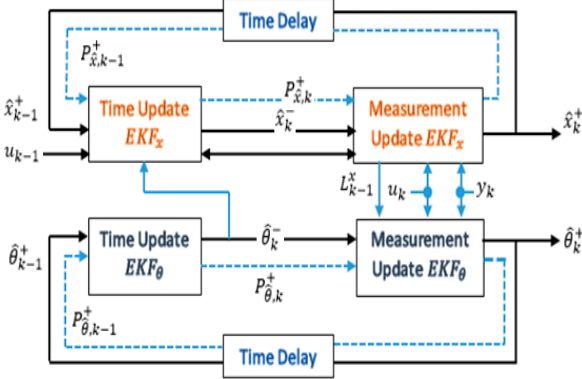
Figure 4. The dual extended Kalman filter (DEKF) process steps.